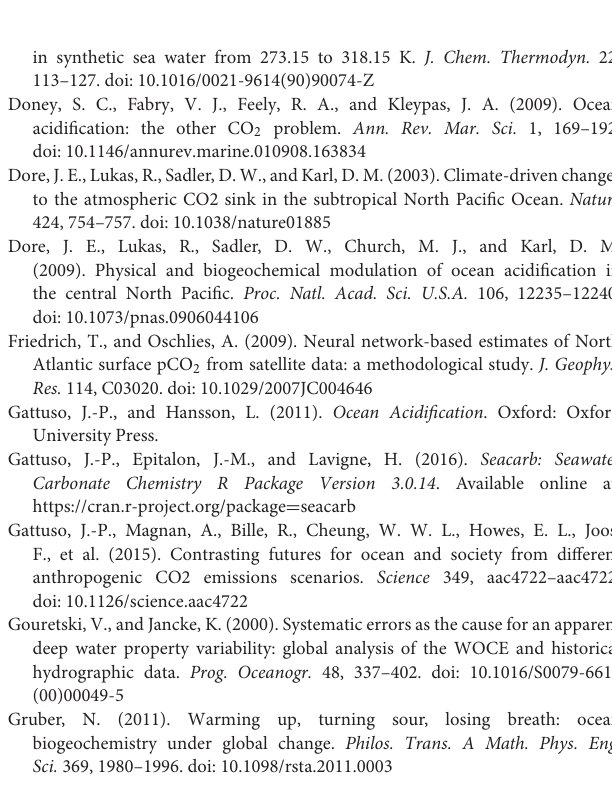
Figure S1 | Geographic boundaries of the seven major oceanic basins used in Section The GLODAPv2 Database. Figure S2 | Temporal distribution of the number of observations (N obs ) available in GLODAPv2 that were used to develop CANYON MLPs, plotted as a function of the sampling months (top) and years (bottom) . The colors refer to the sampling latitude: North high latitudes ( 45 ◦ ); North mid latitudes ≥ ( 15 ◦ and < 45 ◦ ); Equatorial latitudes ( > 15 ◦ and < 15 ◦ ); South mid latitudes ≥ − ( > –45 ◦ and 15 ◦ ), and South high latitudes ( 45 ◦ ). ≤− ≤− Figure S3 | Box plots of the difference between CANYON estimates minus GLODAPv2 reference measurements for the seven variables: NO 3 − ( µ molkg − 1 ), PO 4 3 − ( µ mol kg − 1 ), Si(OH) 4 ( µ molkg − 1 ), pH T , A T ( µ molkg − 1 ), C T ( µ molkg − 1 ), and p CO 2 ( µ atm) vs. the range of the variable retrieved (output variable). The intensity of the shading in each box refers to the number of data. The intervals were created by sharing the range of values in eight regular intervals. For each box, the lower and upper whiskers represent the Q1–1.5 ∗ IQR and Q3 1.5 ∗ IQR, respectively, with Q1 the 0.25 + quantile, Q3 the 0.75 quantile, and IQR the inter-quantile range. The width of each box represents the IQR and the middle line the median of the values. Figure S4 | Time series (22 years) of the temperature (a) , the salinity (b) , and the O 2 (c) measured at HOT. The five profiles from 25 February 2003 to 29 March 2003 that had been removed from the time-series because of their abnormal O 2 profiles are shown with the black triangle in the panel (c) —(see details in Section Example of Application: Illustration with HOT